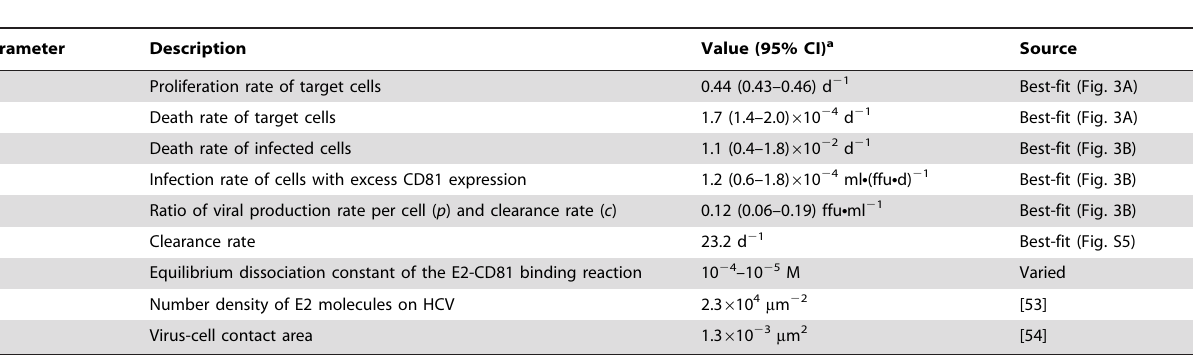
a Typical values employed. Variations are indicated in the text and in figure legends.